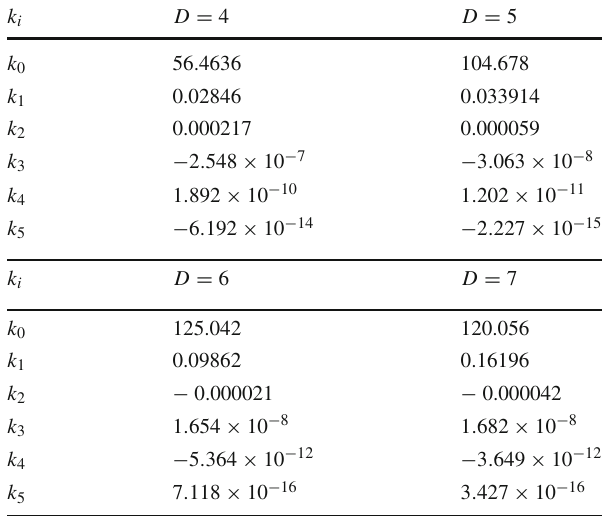
Table 2 Values of coefficients k i in different dimensions for HER X-1 taking α = 0 . 1 and γ = 0 .